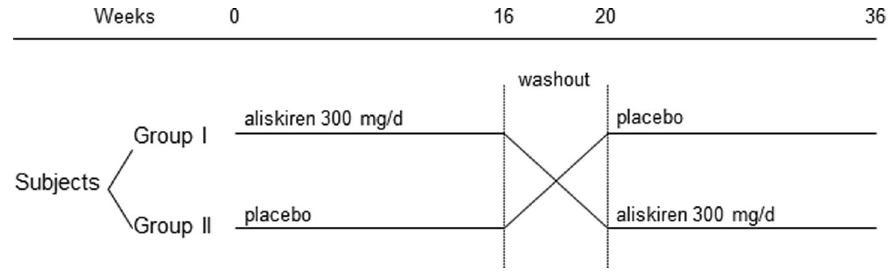
Figure 1. Summary of the study design and overall arrangement of treatment.